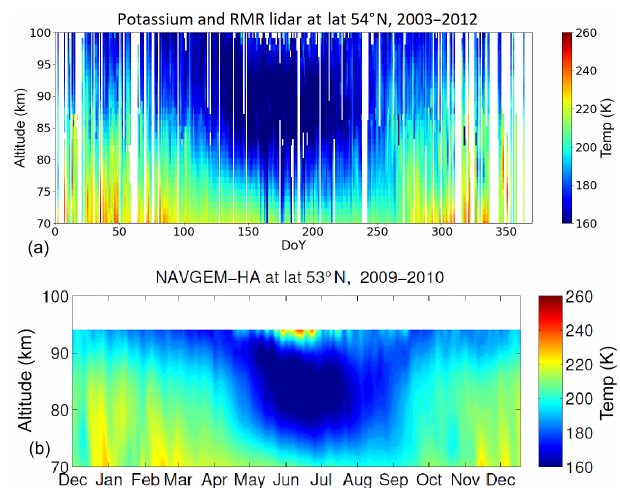
Figure 2. Comparison of mean temperatures above Kühlungsborn. Panel (a) shows the temperatures derived from the potassium lidar. Panel (b) shows the NAVGEM-HA analysis field for the same loca-